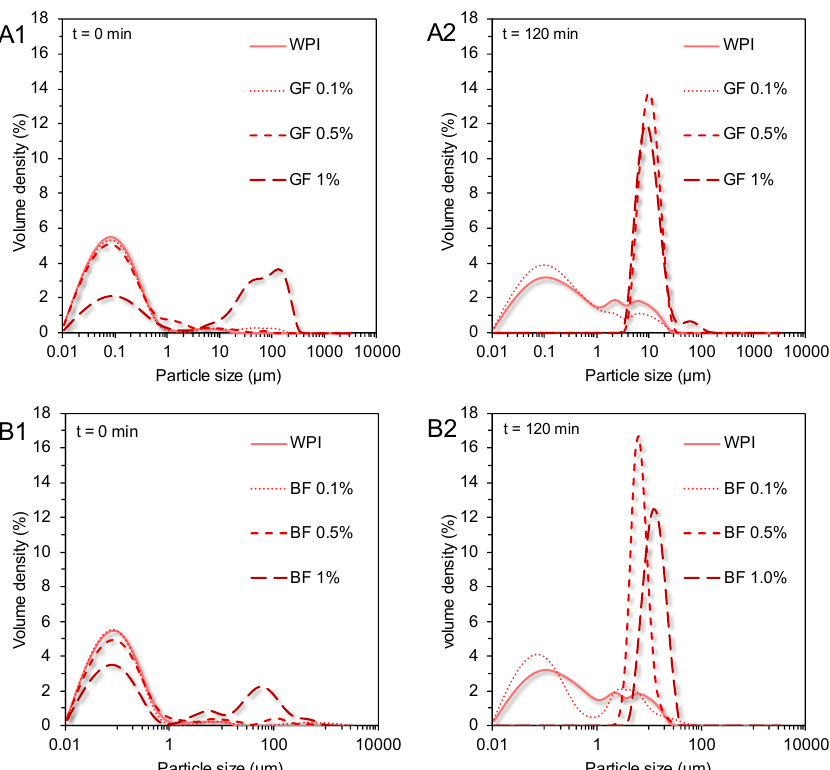
Figure 6. Particle size distribution profiles of the initial and end WPI-based gastric phases ( 1 : t = 0 min and 2 : t = 120 min) as influenced by the phenotype and concentration of flaxseed gum. ( A1,A2 ) = Golden flaxseed and ( B1,B2 ) = Brown flaxseed.